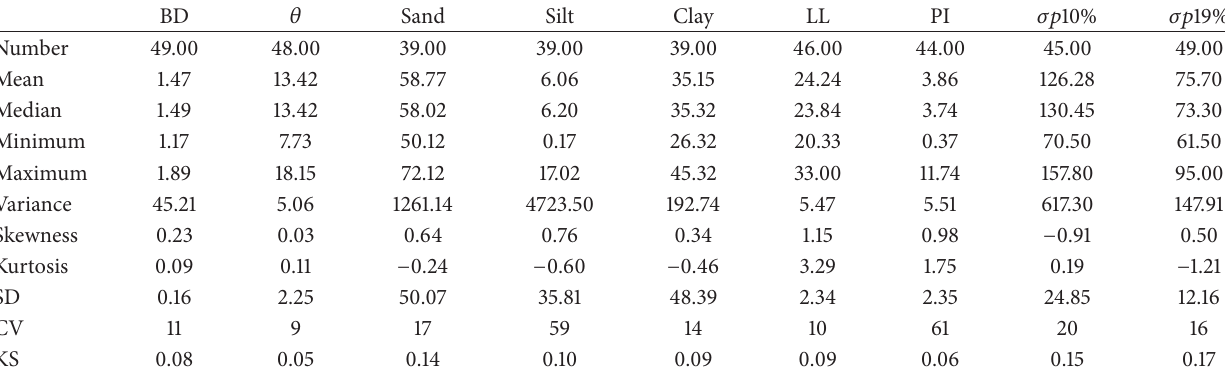
Table 2: Statistical attributes for the parameters under study.